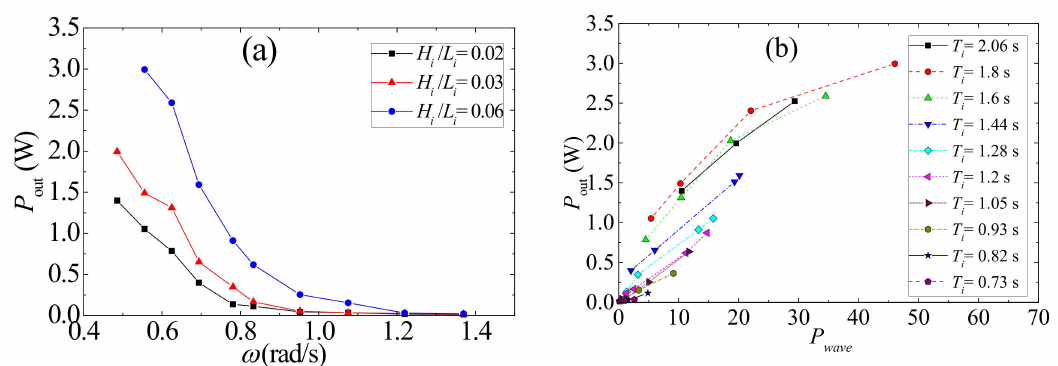
Figure 13. Average output power of the hybrid system with di ff erent wave frequency and incident wave power values: ( a ) e ff ect of wave frequency; ( b ) e ff ect of incident wave